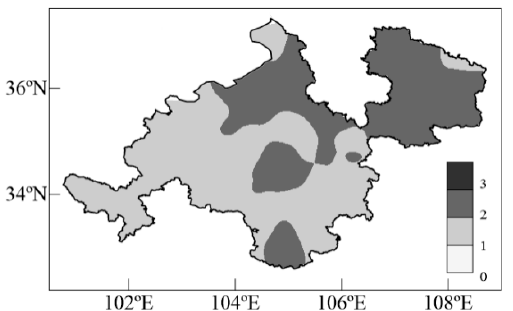
Figure 2. Average number of drought processes from 1960 to 2017 (units: numbers/per year). The average drought duration was approximately 2 months in the period from 1960 to 2017 (Figure 3a). Average duration was less than 50 days in most southwestern regions, while the persistent period lasted 50–60 days in other regions. The longest drought process lasted for 180–270 days (Figure 3b), that is, continuous drought for 2 to 3 seasons. The longest drought process that occurred in the northern and southern regions lasted for 389 days. The droughts occurred from November 1979 to December 1980 and from January 1996 to February 1997, respectively, and began in autumn or winter and continued over a year.